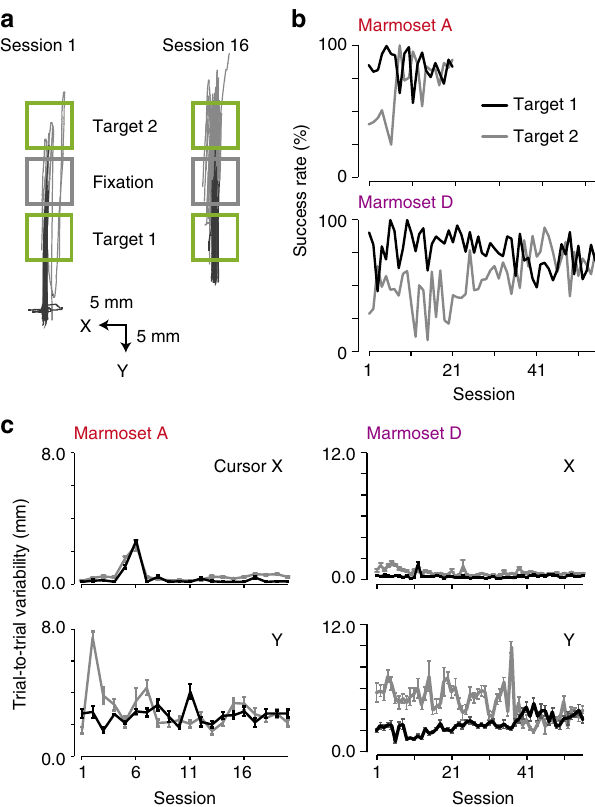
Fig. 4 Learning of the two-target reaching task. a Reaching trajectories in sessions 1 and 16 of the two-target reaching task in marmoset A. Black and gray solid lines represent reaching trajectories for the targets below (target 1) and above (target 2) the fi xation square, respectively. Other conventions are the same as in Fig. 3c. b Time course of the success rates for different targets in marmosets A (top) and D (bottom). CCs between the success rate for target 1 and session number were − 0.23 for marmoset A, P = 0.32, and − 0.44 for marmoset D, P < 0.01. CCs between the success rate for target 2 and session number were 0.68 for marmoset A, P < 0.01, and 0.61 for marmoset D, P < 0.01. c Time course of the trial-to-trial variability of the successful reaching trajectory to targets 1 (black) and 2 (gray) in marmosets A (left) and D (right). For marmoset A, CCs between the variability of the reaching target 1 and session number were − 0.05 and 0.01, P = 0.84 and P = 0.97, for X and Y coordinates, respectively. CCs for the variability of reaching target 2 were 0.25 and − 0.18, P = 0.27 and P = 0.44, for X and Y coordinates, respectively. For marmoset D, CCs for the variability of reaching target 1 were 0.08 and 0.72, P = 0.54 and P < 0.01, for X and Y coordinates, respectively. CCs for the variability of reaching target 2 were − 0.39 and − 0.64, P < 0.01 and P < 0.01, for X and